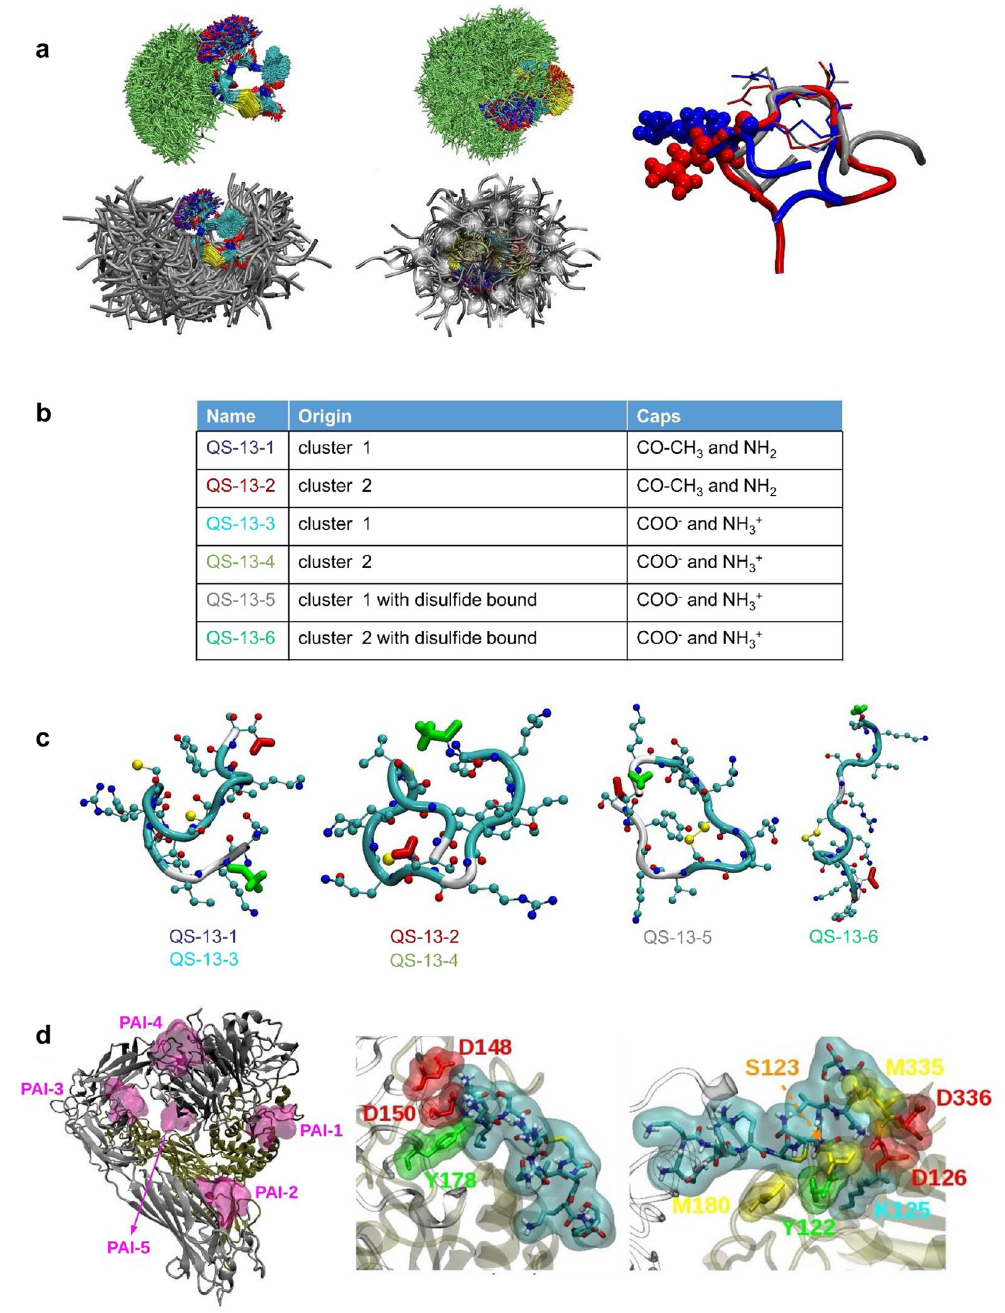
Figure 4. Molecular Dynamics simulation and docking of the QS-13 peptide. ( a ) The snapshots extracted from MD simulations of the QS-13-db (left panel) and QS-13 (central panel) peptides were superimposed using the α carbons of the CQVC central sequence. A first type of display (upper panel) is obtained with the licorice representation picturing the CQVC central residues (atom color coded) and the Arginine residue (in light green). The second type of display (lower panel) is obtained using the licorice representation for the CQVC central residues (atom color coded) and the new cartoon representation for the backbone (in silver). Finally, superimposition of the first cluster of the disulfide bonded peptides was performed (right panel). The structures of the AS-13-db (in red), QS-13-R5A-db (in silver) and QS-13-db (in blue) were superimposed using the α carbons of the CQVC central sequence. The backbone is displayed using the new cartoon representation, the CQVC sequence using the licorice representation and the Arginine residues using the Van der Waals representation. ( b ) Specification of the QS-13 peptides characteritics related to the origin of the cluster (family of conformation) and the nature of the termini. ( c ) Representative conformation of QS-13 peptides. N-termini are displayed in green licorice and C-termini in red licorice. The backbone of the peptides is colored according to its local secondary structure (cyan for turn and white for coil) and the sulfur atoms are shown as yellow spheres. ( d ) The results of the QS-13-3 docking experiment highlight the existence of 5